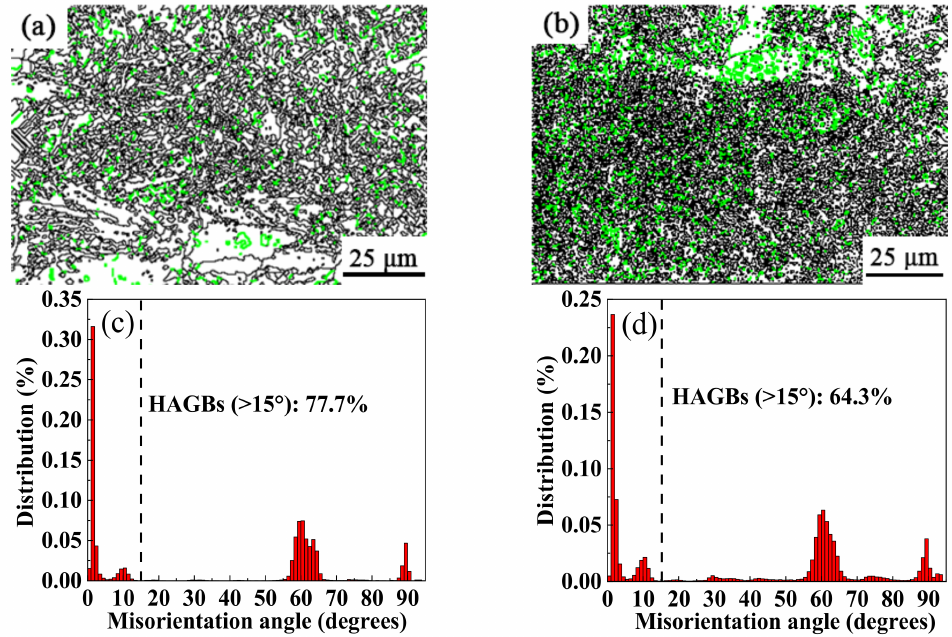
Figure 6. Distribution of grain boundary misorientation and HAGB ratio of SLM-formed